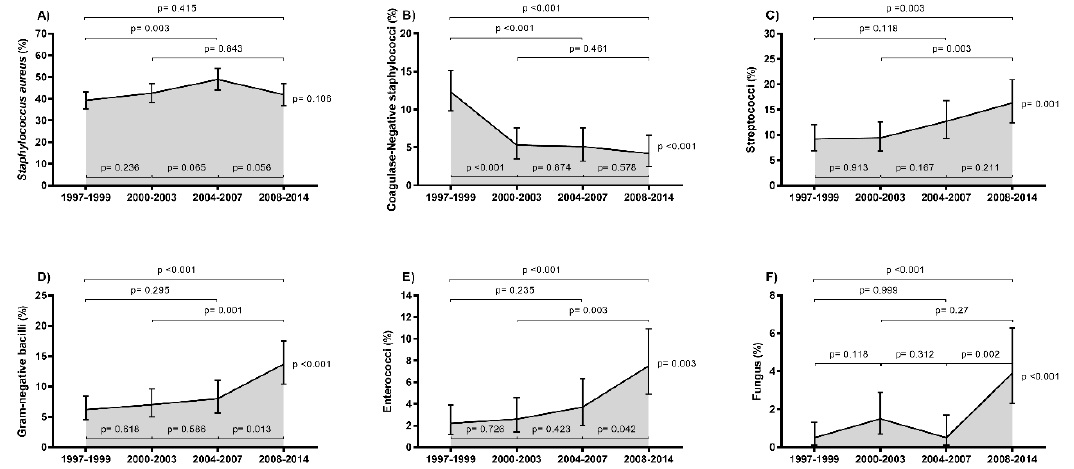
Figure 3. Epidemiological trends of causative microorganisms of infective endocarditis in HIV-infected patients in Spain (1997 to 2014). ( A ) Staphylococcus aureus . ( B ) Coagulase-Negative staphylococci. ( C ) Streptococci. ( D ) Gram-negative bacilli. ( E ) Enterococci. ( F ) Fungus. Statistical: Di ff erences between groups were calculated by the Chi Square test. Linear trends from 1997–1999 to 2008–2014